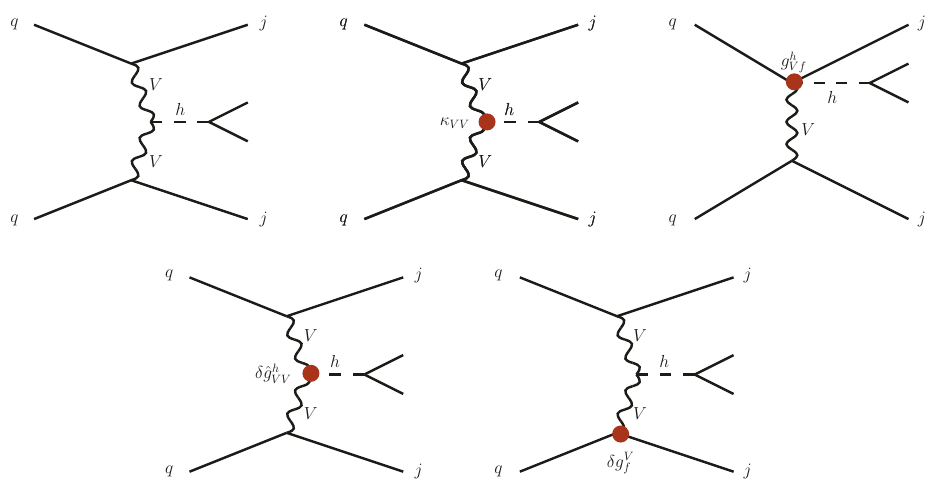
Figure 2 . Figure shows representative VBF topologies in the SM and in the SMEFT. The red dots signify modified vertices from the EFT couplings in eq. (2.2). The figure has been produced with the help of the JaxoDraw package